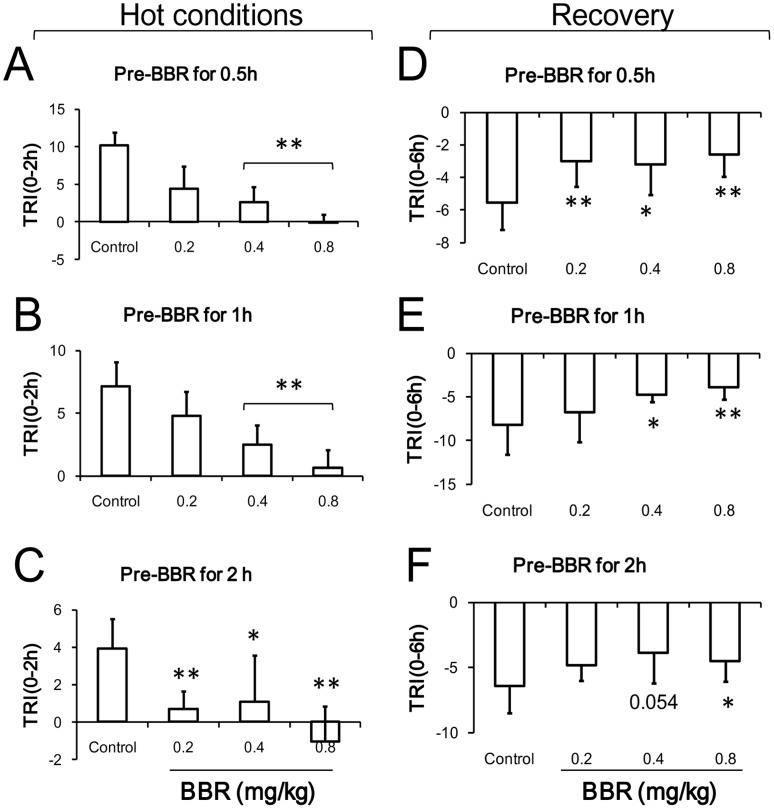
The alteration of core temperature of mice in hot conditions after berberine (BBR) injection.A–C: the data of thermal response index (TRI) during hot conditions (2 hours). A: BBR injection at 0.5 h prior to hot conditioning. F (3, 36) = 40.902, P<0.001. B: BBR injection at 1 h prior to hot conditioning. F (3, 36) = 26.683, P<0.001. C: BBR injection at 2 h prior to hot conditioning. F (3, 36) = 12.702, P<0.001. D–F: the TRI (6 hours) of the recovery after hot conditioning. D: BBR injection at 0.5 h prior to hot conditioning. F (3, 36) = 5.759, P = 0.0028. E: BBR injection at 1 h prior to hot conditioning. F (3, 36) = 6.018, P = 0.0019. F: BBR injection at 2 h prior to hot stimulation. F (3, 36) = 3.423, P = 0.0273. Data were shown as mean ± S.D. from ten independent mice (n = 10). * v.s. the control group, P<0.05. ** v.s. the control group, P<0.01.